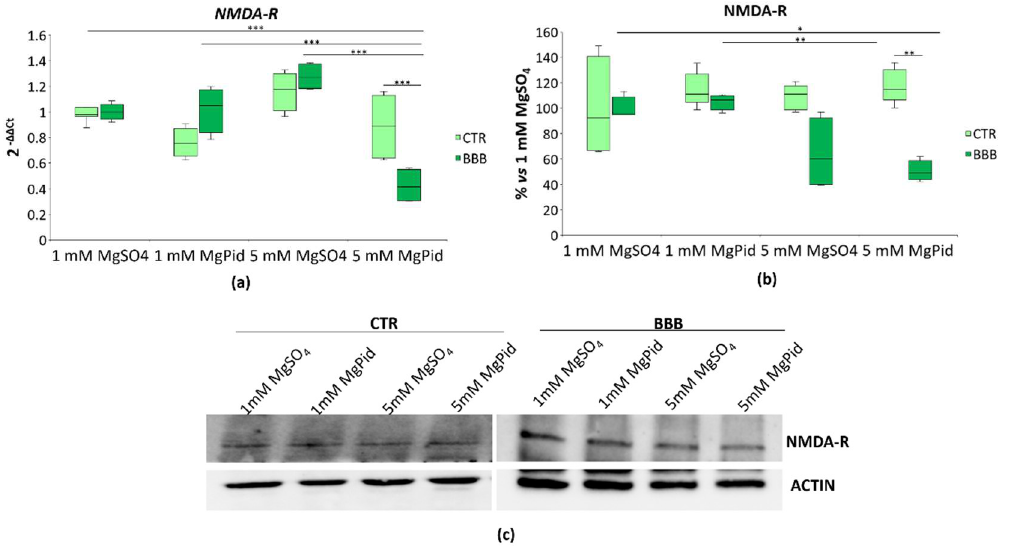
Figure 2. NMDA-R in brain organoids in the presence or absence of the BBB. Human brain organoids were cultured with (BBB) or without (CTR) the BBB, and exposed to 1 or 5 mM MgPid or MgSO 4 for 4 days. Each experimental sample was obtained by pooling three organoids. ( a ) Box plot shows the real-time PCR performed three times in triplicate on RNA extracted from the brain organoids. Primers were designed on GRIN1 ( NMDA-R ) sequence. The mRNA expression values were normalized to GAPDH mRNA levels; ( b ) Western blot was performed using antibodies against the subunit 1 of the NMDA-R. Actin was used as a control of loading. Box plot shows the quantification of five independent Western blots. Each box represents the interquartile range (25th to 75th percentiles), the horizontal line inside is the median value, and the whiskers represent the range; ( c ) A representative Western blot is shown. Two-way ANOVA was performed. * p ≤ 0.05, ** p ≤ 0.01, *** p ≤ 0.001.